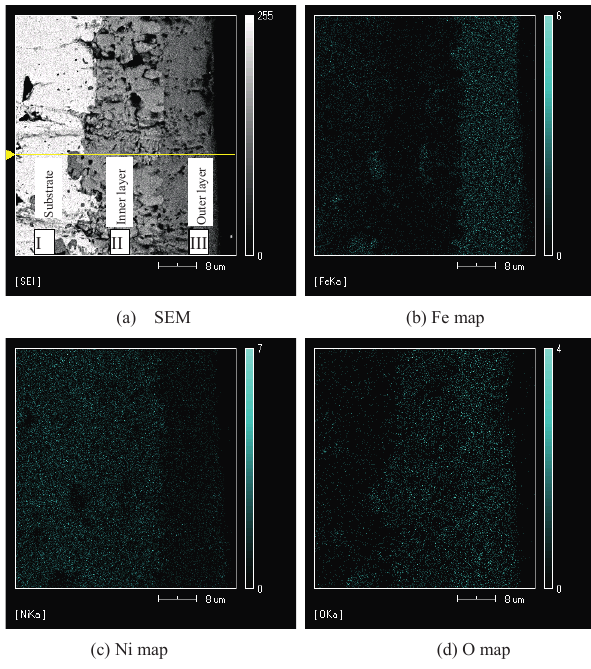
Figure 5. Cross-sectional morphology of oxide scale of 20Fe-80Ni alloy oxidized at 800 ı C.